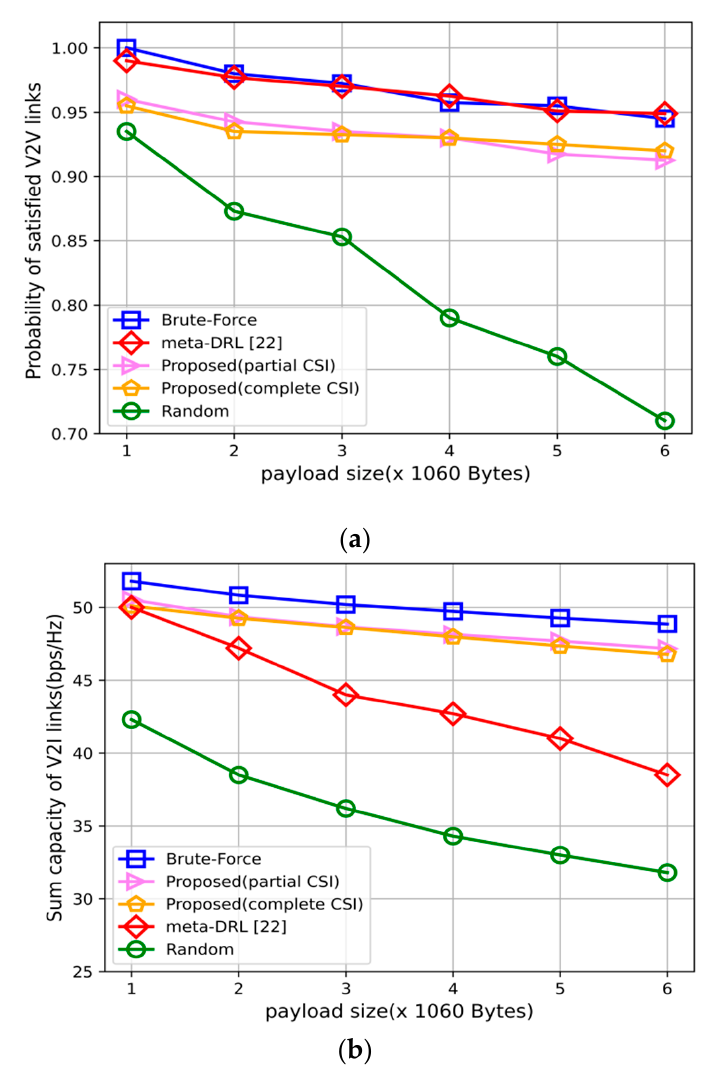
Figure 3. Performance comparisons with different payload sizes. ( a ) V2V payload transmission success probability with varying payload sizes. ( b ) Sum capacity performance of V2I links with varying payload sizes